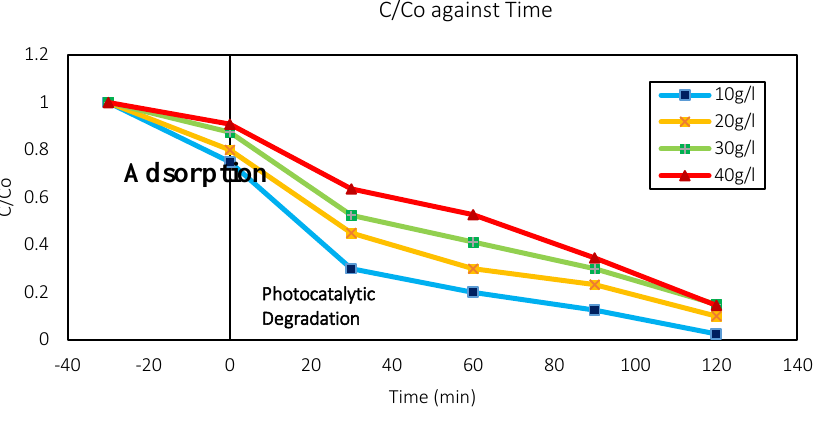
Figure 5: Effect of initial concentration on LaFeO3 of adsorption and photocatalytic degradation HA (pH = 6, HA = 10 mg/L, Catalyst dosage = 0.1-gram, contact time = 120 minutes).